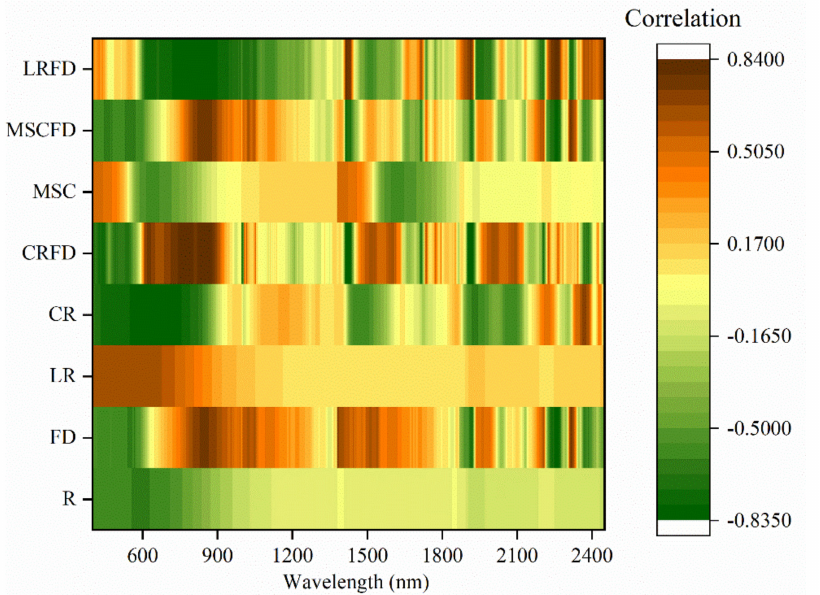
Figure 4. The correlation coefficient between SOC content and eight spectral transformations data (SOC is the soil organic carbon, R is the original spectrum merely using Savitzky–Golay smooth filtering, FD is the first-order differential, LR is the logarithmic reciprocal, CR is the continuum removal, MSC is the multivariate scattering correction, and CRFD, MSCFD, and LRFD are the FD based on CR, MSC and LR,